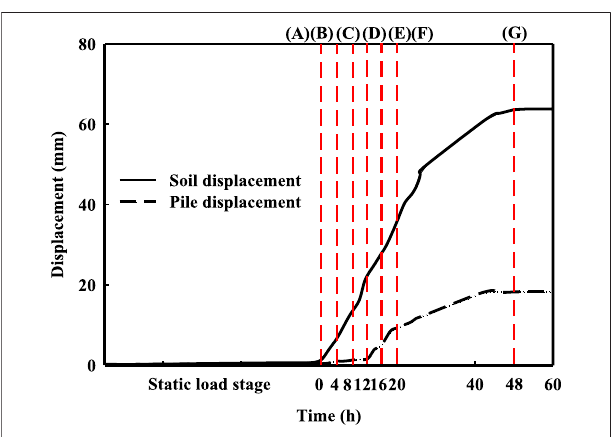
FIGURE 8 | Variations of pile axial force distribution of PITE.